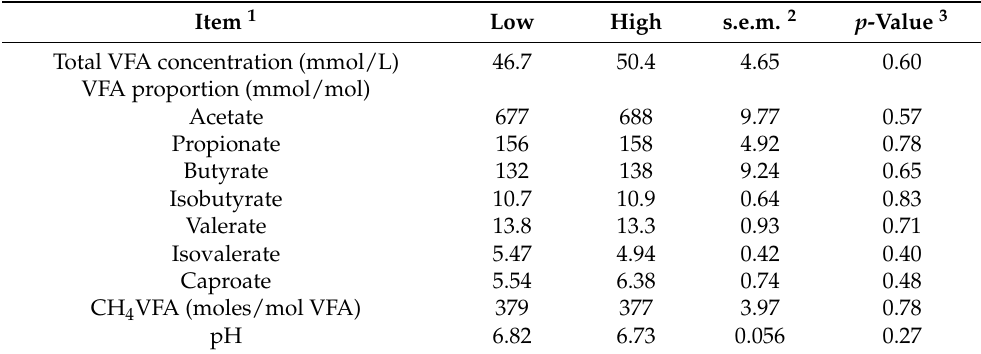
1 CH 4 VFA = Stoichiometry CH 4 per mol of volatile fatty acids [23]; of the difference among groups (low vs. high emitters) according to a completely randomized design with the effect of pair of cows as a covariate in the